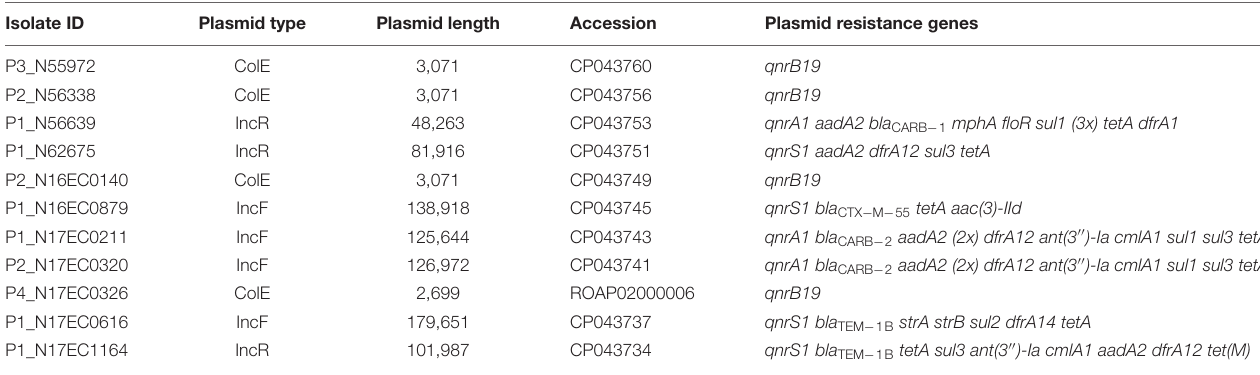
TABLE 2 | Characteristics of PMQR